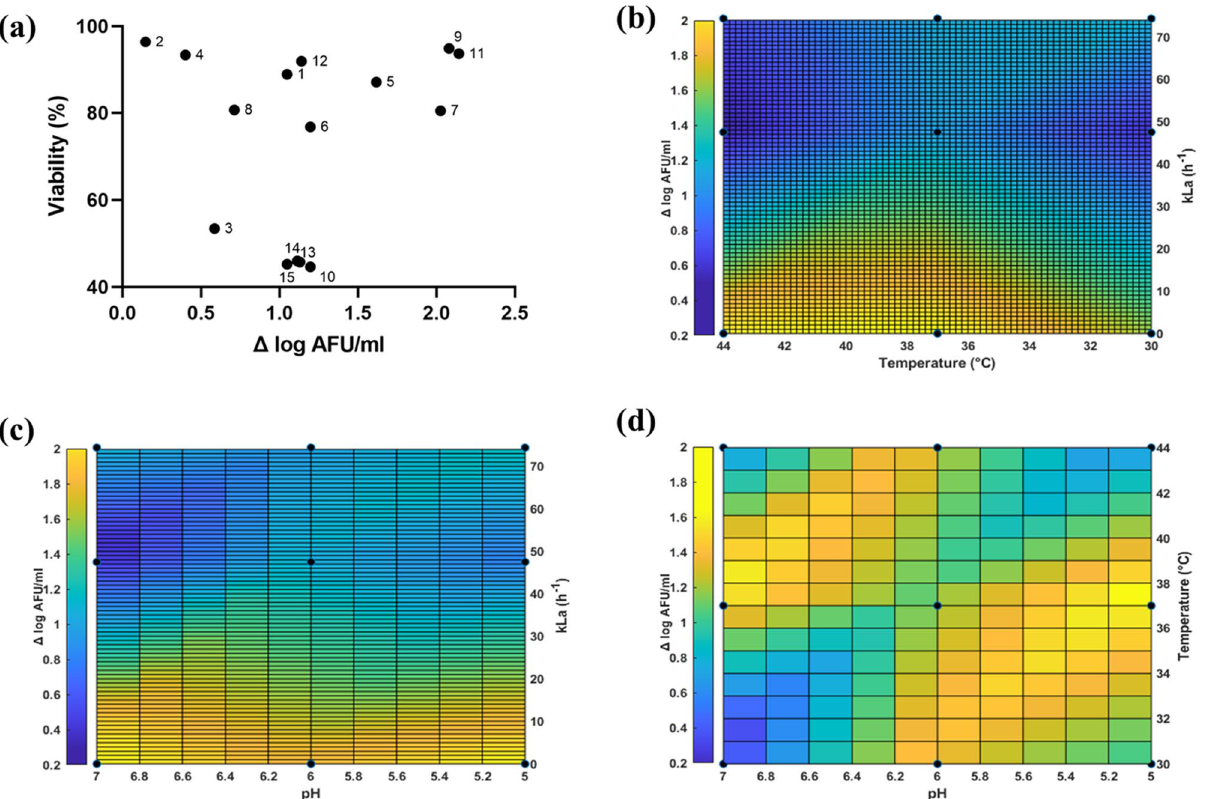
Figure 1. Growth and Viability. Viability is defined as the ratio of intact cells and total cells ( a ) Evaluation of viability (%) as a function of growth (Δ log AFU/ml). The graph indicates 3 clusters indicating viability is independent of growth (Correlation coefficient r = 0.3723, p-value > 0.05). Surface plots of ( b ) pH and oxygen rate (kLa (h −1 )) ( c ) Temperature and oxygen rate (kLa (h −1 )), ( d ) pH and temperature against growth (Δ log AFU/ml). The intensity is displayed by the scale bar, blue colour denotes low growth (Δ log AFU/ml) and yellow colour denotes high growth (Δ log AFU/ml).